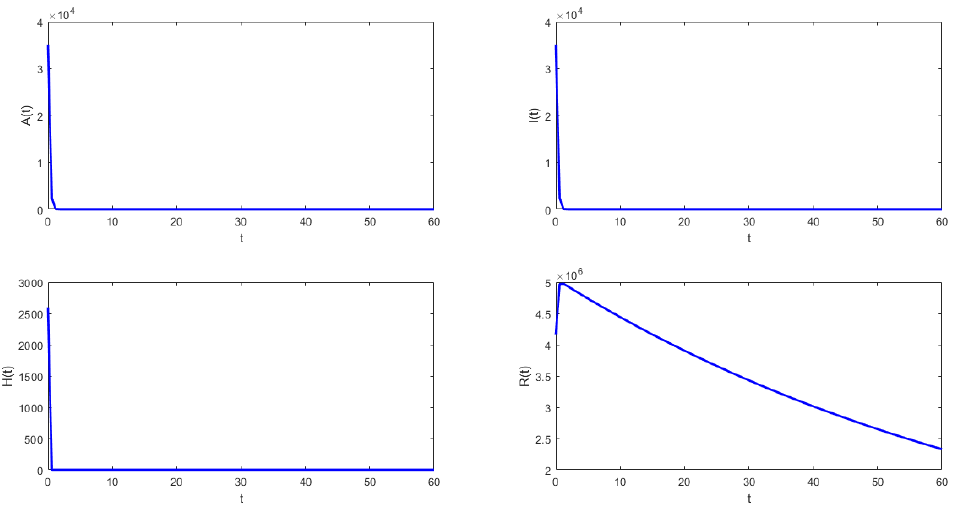
Figure 3. Numerical simulation of system (1) with the following values for the